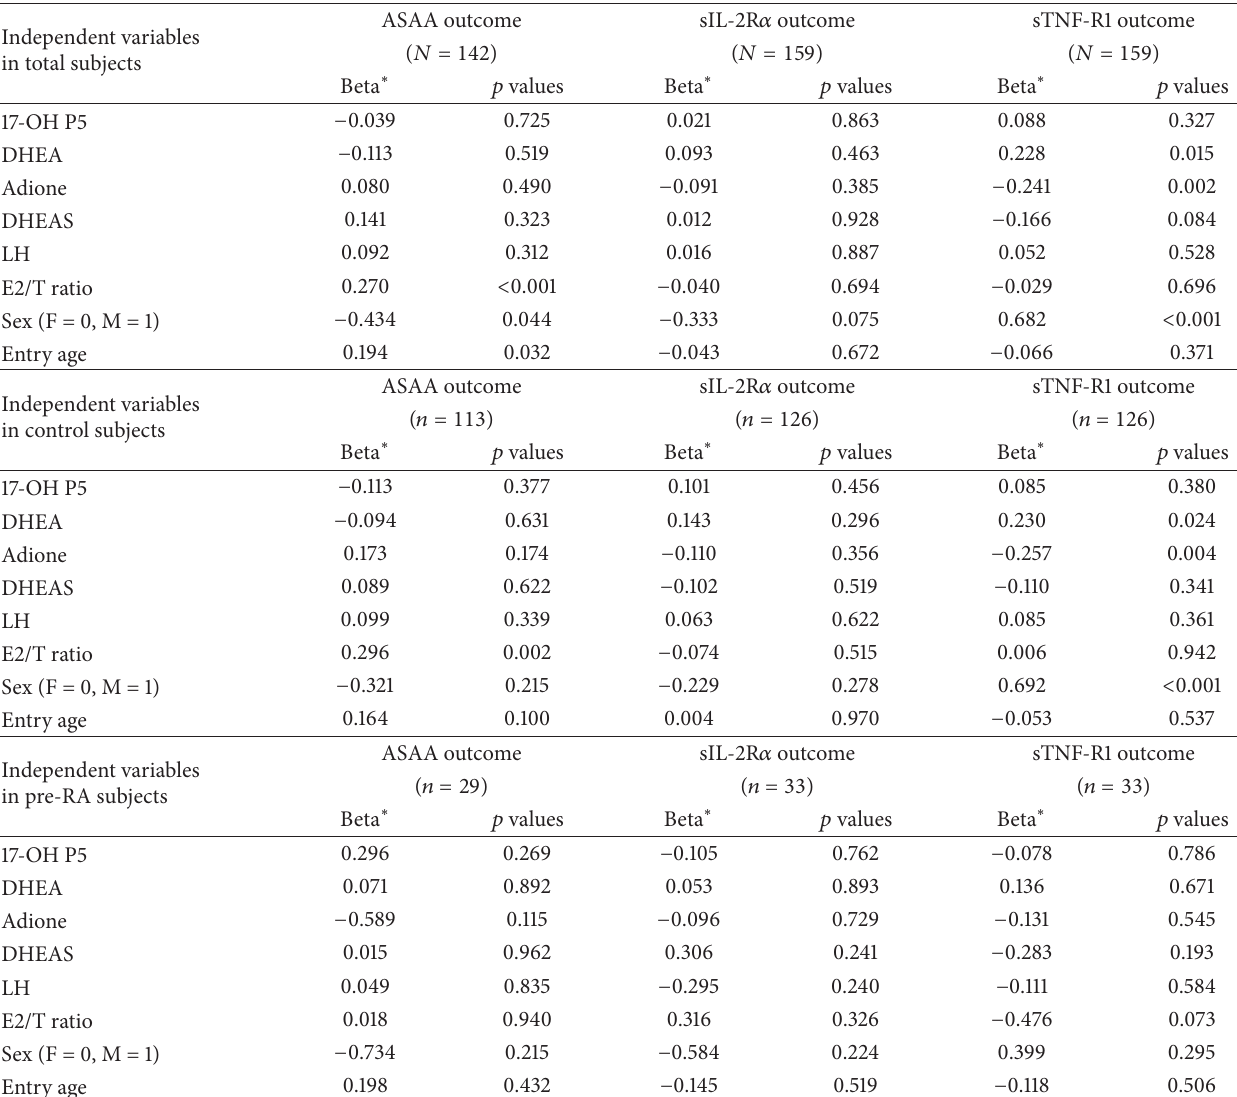
Table 6: Multiple regression model of serum inflammatory biomarker outcomes including variables that predicted sex plus E2/T ratio and actual sex